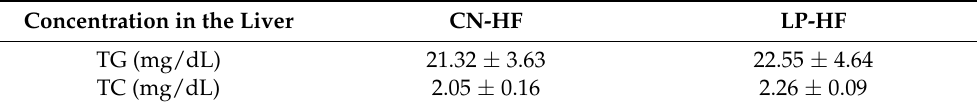
Table 2. Hepatic biochemical markers.